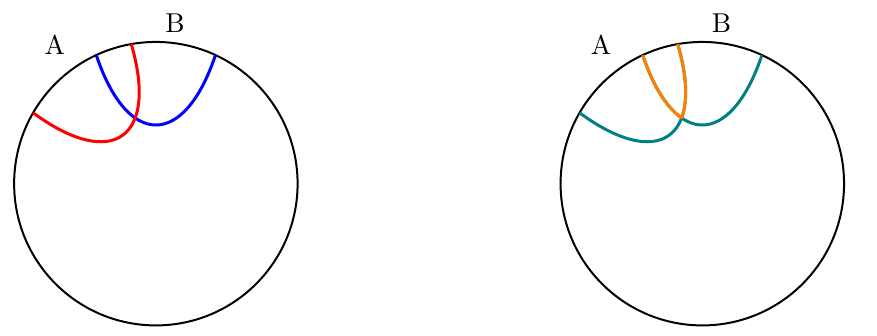
Figure 9. Strong subadditivity: since S A ∪ B ≤ S green and S A ∩ B ≤ S orange = ⇒ S A ∪ B + S A ∩ B ≤ S A + S B